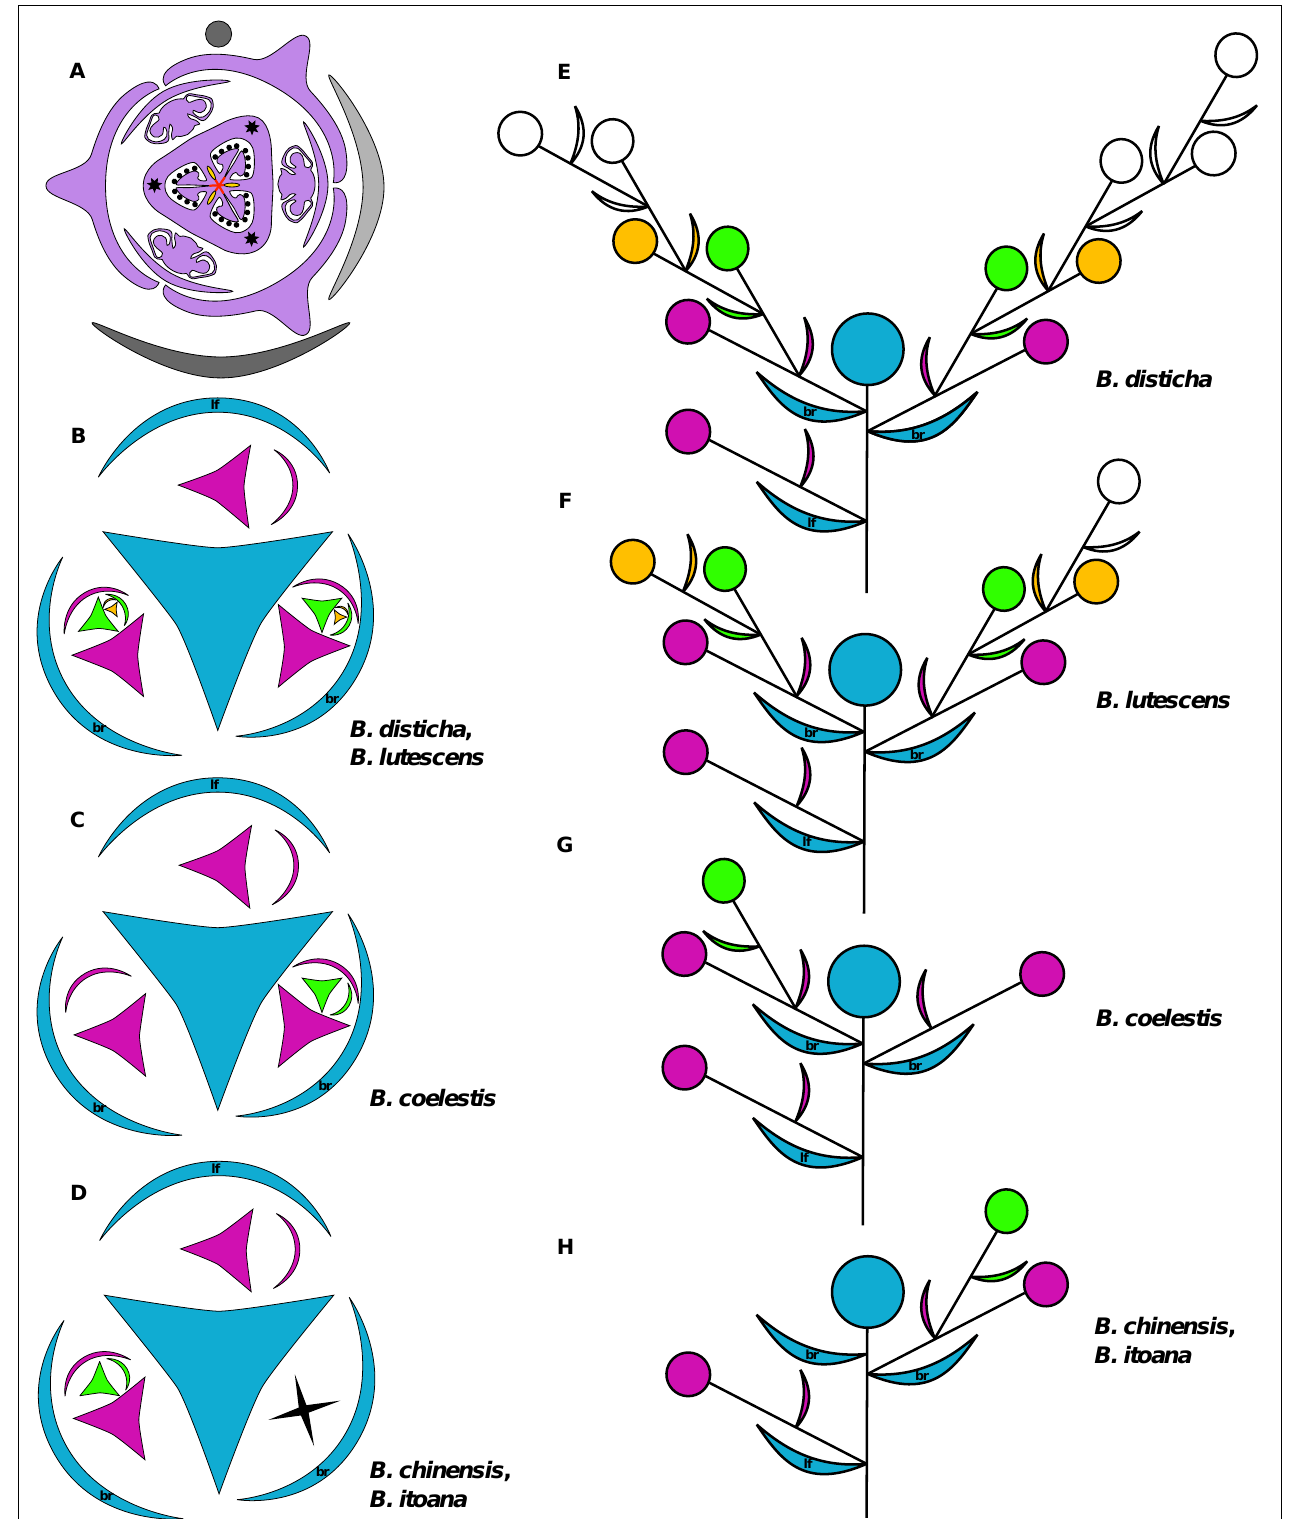
FIGURE 1 | (A) Diagram of lateral flower of the species of Burmannia studied here; asterisks indicate position of styles; red lines: postgenital fusion; yellow areas: septal nectaries. (B–H) Diagrams of the inflorescence structure of Burmannia : groundplan, with shape of flower indicating position of perianth wings and outer tepals (B–D) ; lateral view (E–H) . br, involucral bract; lf, stem leaf.